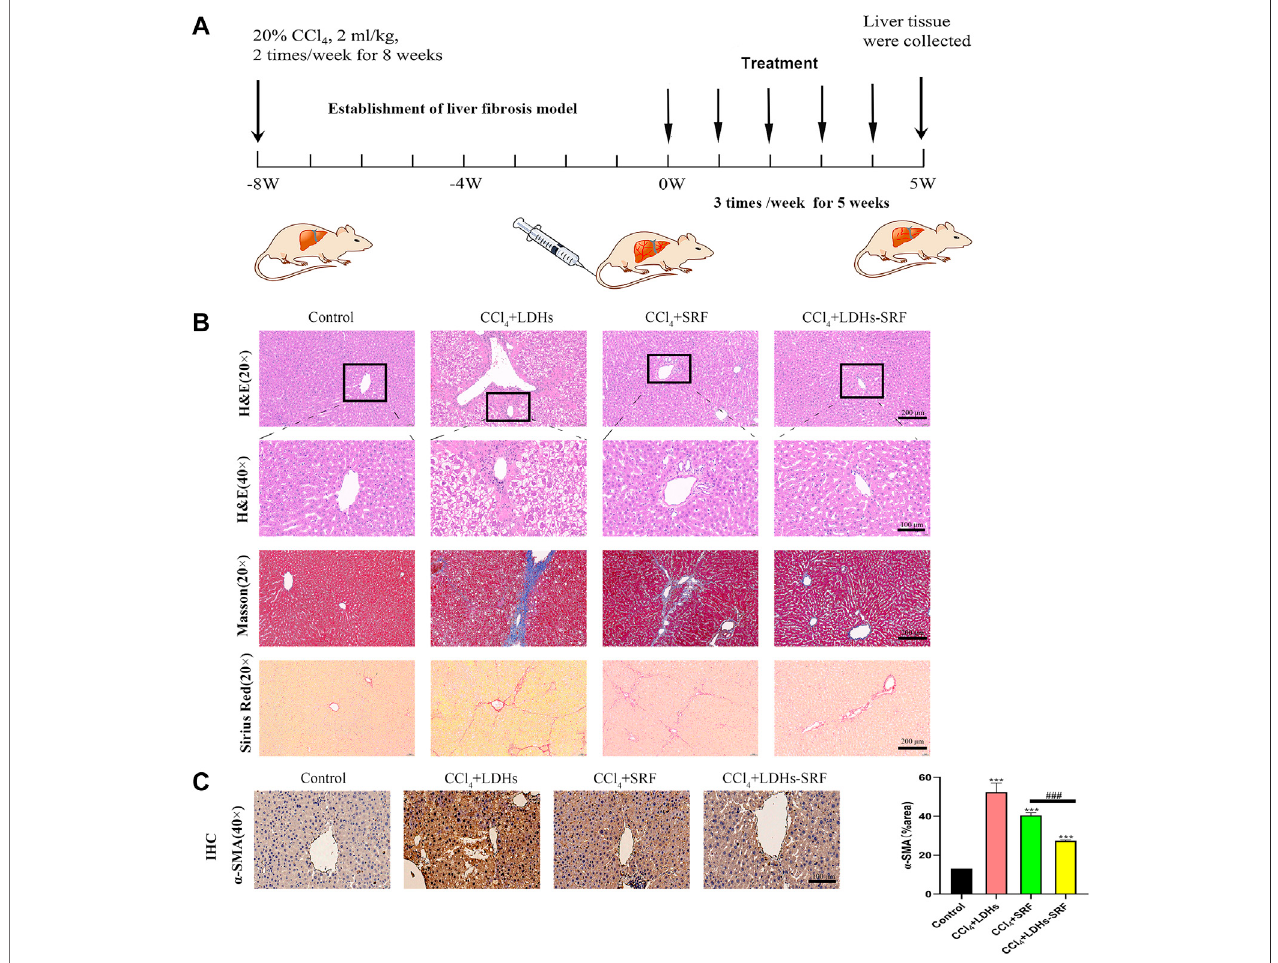
FIGURE 6 | The therapeutic effect of LDHs-SRF on CCl 4 -induced liver fi brosis model in SD rats. (A) Flow chart of CCl 4 -induced liver fi brosis model in SD rat; (B) Representative of H&E, masson and sirius red staining of liver tissue section; (C) Representative of immunohistochemical staining and quantitative analysis graphs of α - SMA in liver tissue section. Data represent mean ± SD ( n = 3) and use one-way ANOVA with Tukey ’ s multiple comparison test, *** p < 0.001 vs. Control, ### p < 0.001.